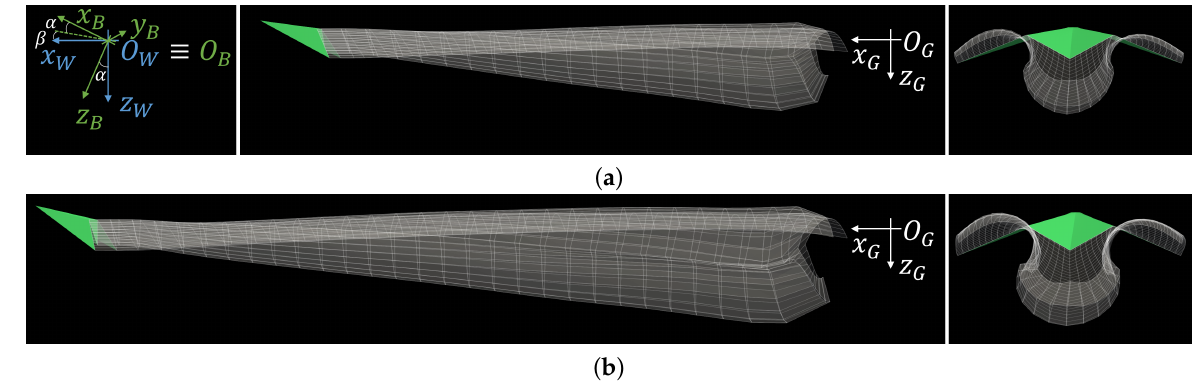
Figure 4. Reference frames and wake in an UnPaM unsteady simulation at the 20th ( a ) and 30th ( b ) times steps. Left image in ( a ) represents the B and W frames orientation (their origins are at the kite CM) on the x G − z G plane at the 20th time step, center and right [left and right] images of ( a , b ) show the x G − z G plane and the y G − z G plane,